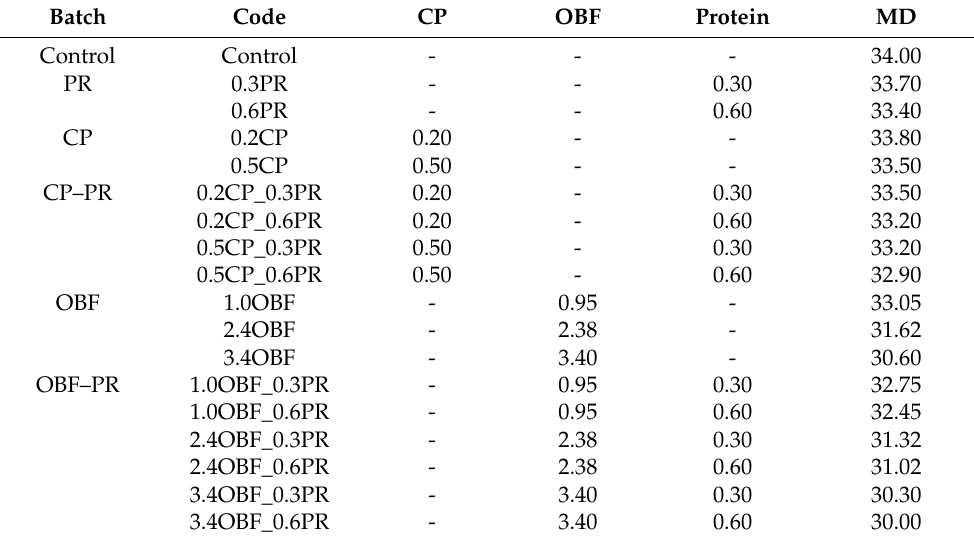
Table 1. Composition of the emulsions prepared in g/100 g of emulsion. All the emulsions contained 60% w / w of water and 6% w / w of oil with or without proteins (PR), commercial pectins (CP), and an orange by-products flour